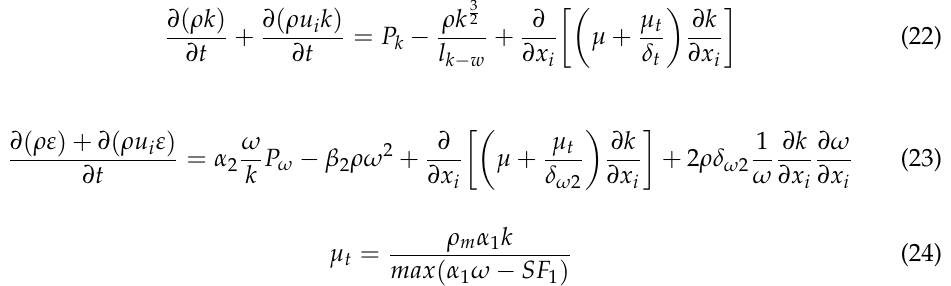
Figure 6. Robustness Analysis of Simulation Process. Table 2. Process parameters of simulation experiment . Parameter